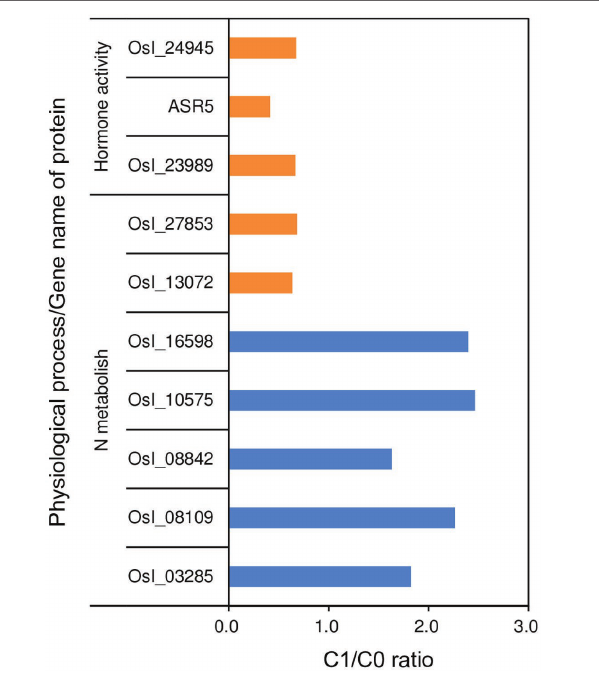
FIGURE 6 | Fold changes in differentially modulated proteins related to N metabolism and hormone activity in roots of rice plants grown with biochar application (C1) compared to plants grown without biochar application (C0). Orange and blue bars represent the down- and up-modulated proteins in the C1 treatment compared to the C0 treatment,